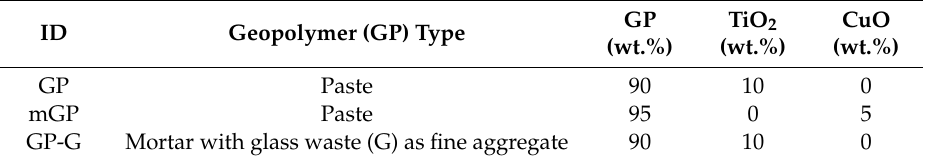
Figure 2. Diagram of the methodology used to prepare the geopolymer composites. Table 1. Compositions of the fabricated materials. ID—identifier.